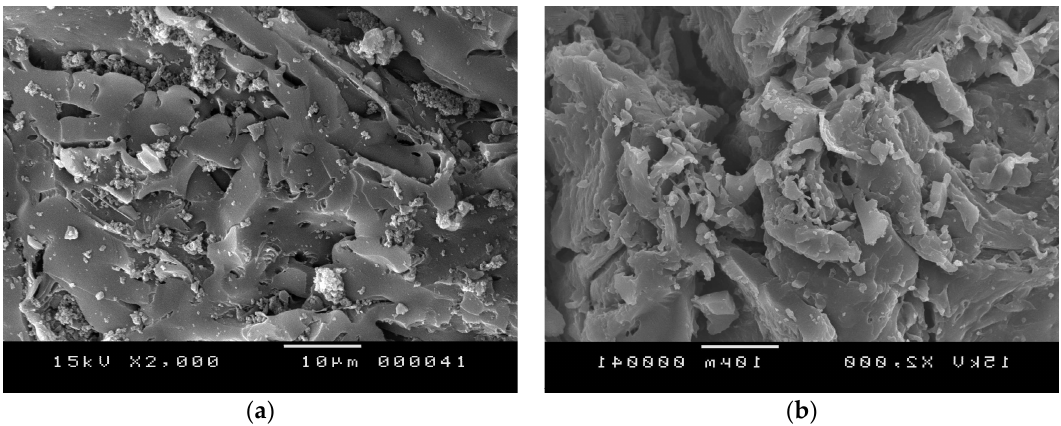
Figure 2. Scanning Electron Microscope (SEM) micrographs of sample two activated carbon (AC) samples with a magnification of × 2000: ( a ) A; ( b ) A-HNO 3 .